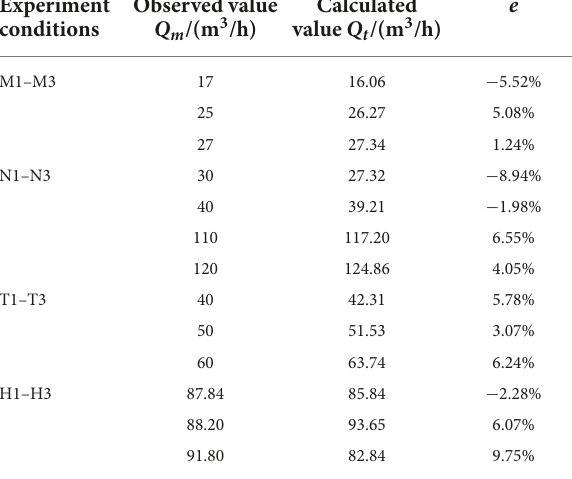
TABLE 4 Relative error in calculating the flow